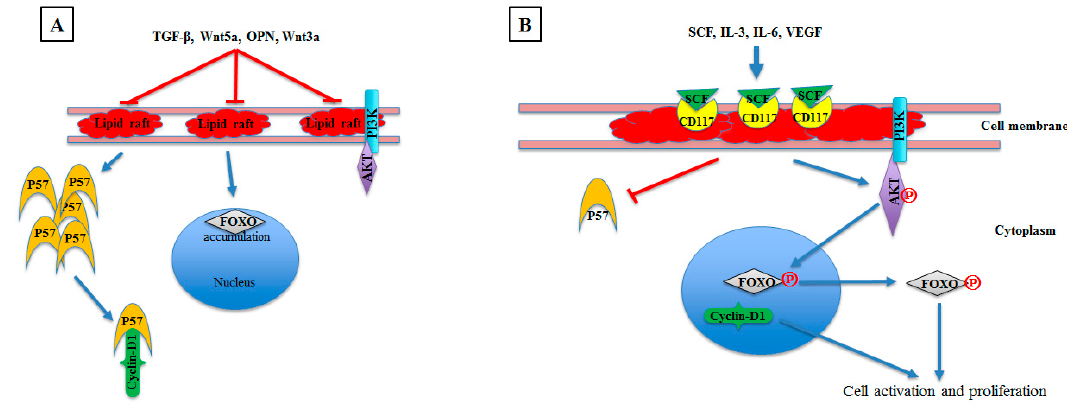
Figure 3. Role of LRs in HSC differentiation. A, HSCs rest in hibernation mode in bone marrow niche under the effect of Wnt5a, OPN, Wnt3a, or TGF- β cytokines. These cytokines decrease LRs clustering, show inactive AKT, abundant p57 Kip2 , and nuclear localization of FOXO transcription factors. Abundant p57 Kip2 binds Cyclin-D1, resulting in inhibition of cell proliferation. B, Activation of LR clustering by SCF or IL-3 or IL-6 or VEGF leads to incorporation of CD 117 in the LR cluster, resulting in simulation of the PI3K–Akt–FOXO pathway. Active AKT ℗ phosphorylates FOXO, resulting in translocation of FOXO from the nucleus to the cytoplasm and initiation of HSC cell cycling. LR clustering and CD117 incorporation also reduce P57 abundance, thus increasing Cyclin-D1 translocation into the nucleus with additional initiation of HSC proliferation.